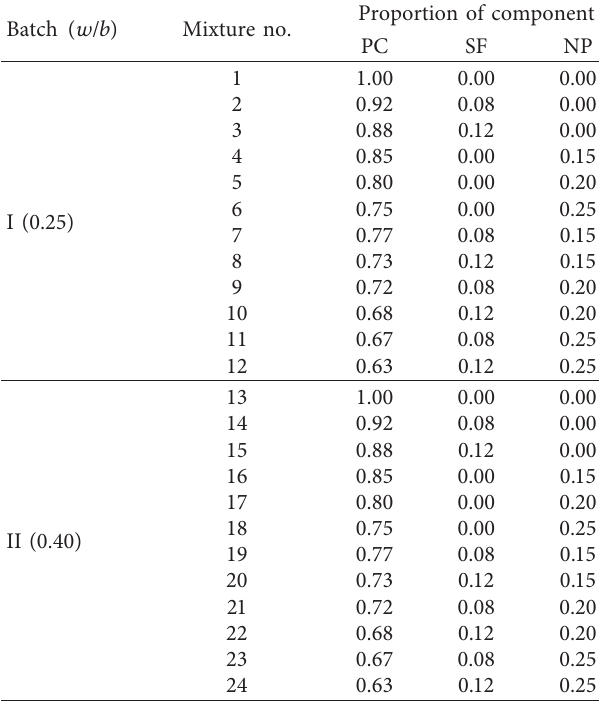
Table 2: Cement proportions of the concrete